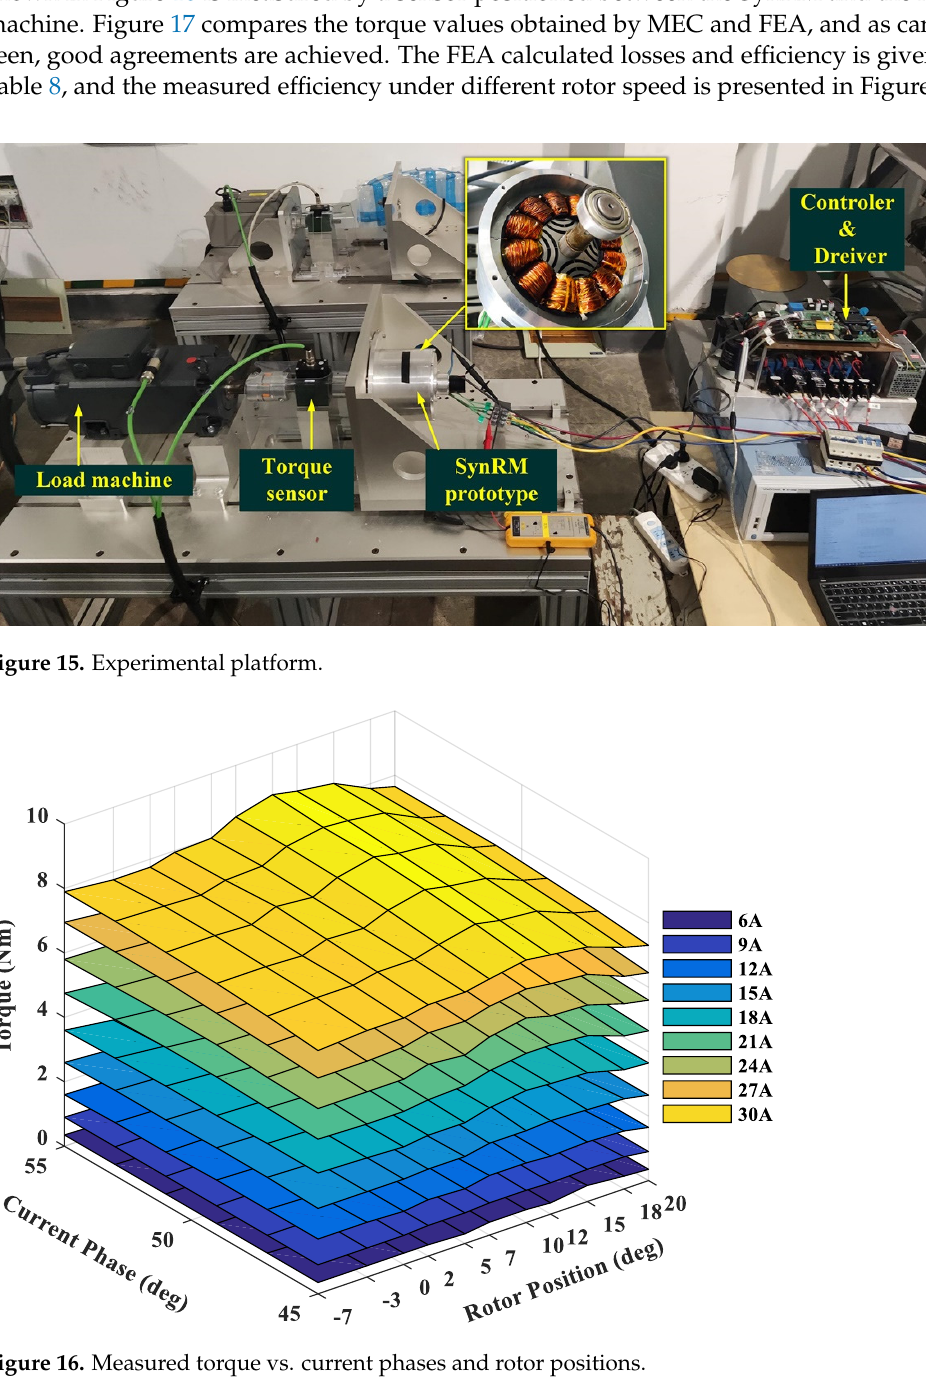
Table 8. Power loss and efficiency at rated operation.